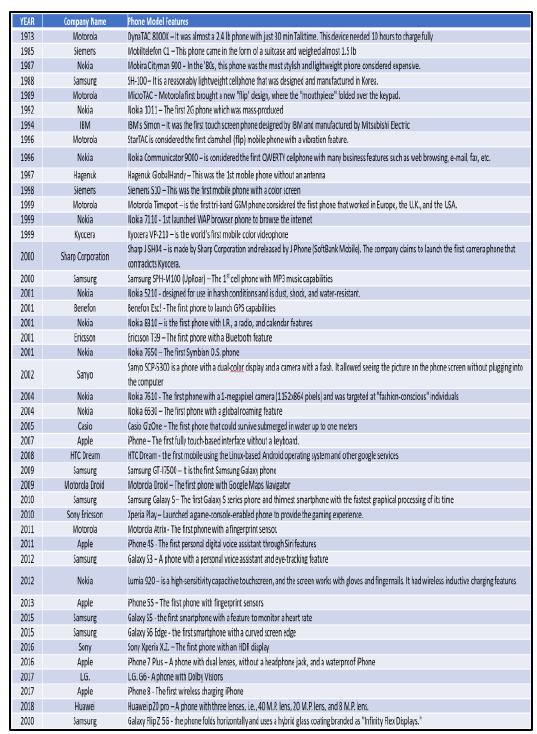
Figure 1. Mobile Phone Brands from 1973 until 2020 Source: (Križanović, 2020; Mobikyo, 2014; Uswitch,